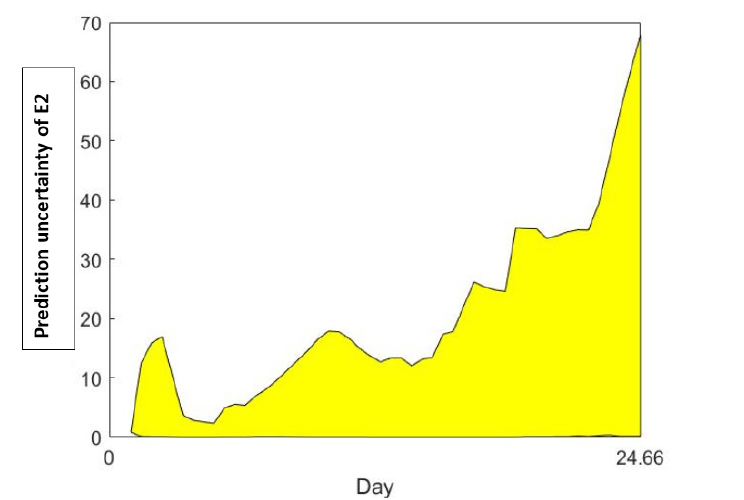
Figure 11. Model E2 Prediction Uncertainty.